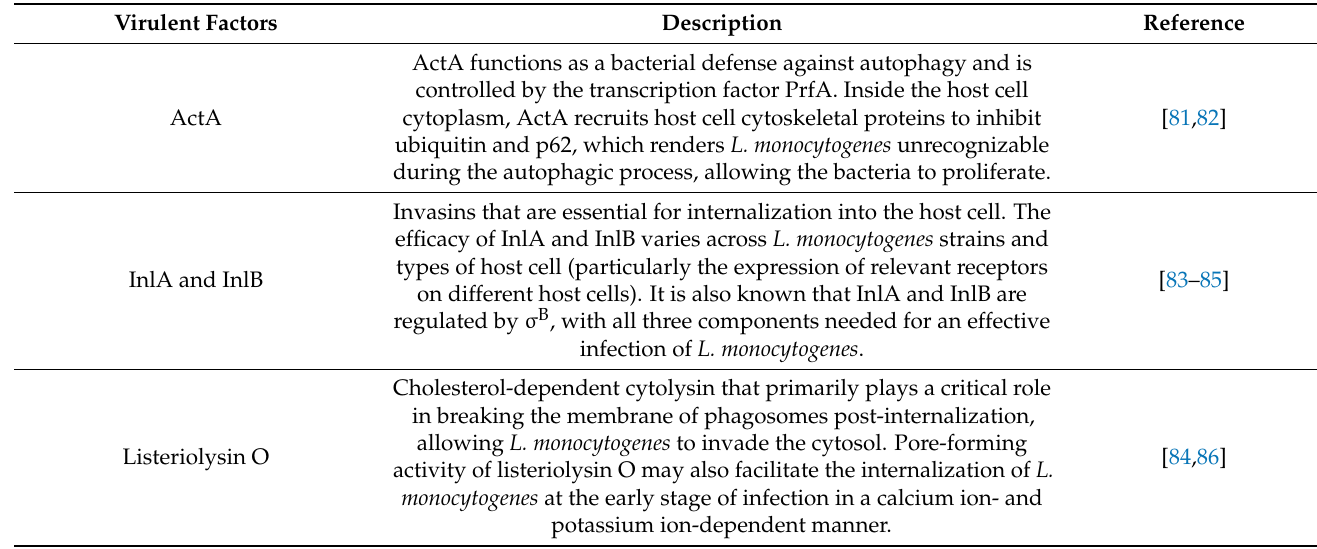
Table 3. Virulence factors in Listeria monocytogenes that are affected, directly or indirectly, by blue light treatments. Virulent